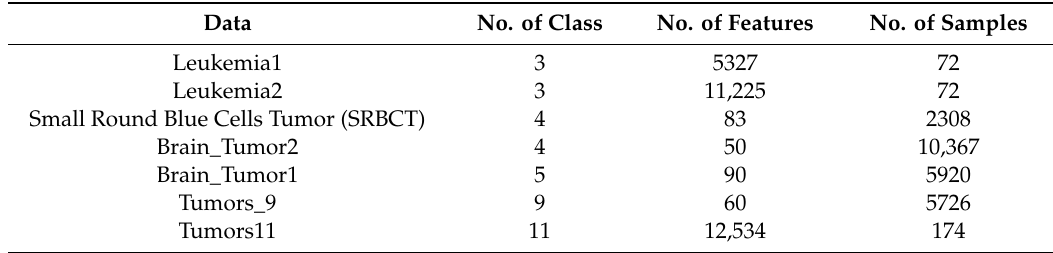
Table 3. Descriptions of microarray data for cancer detection.